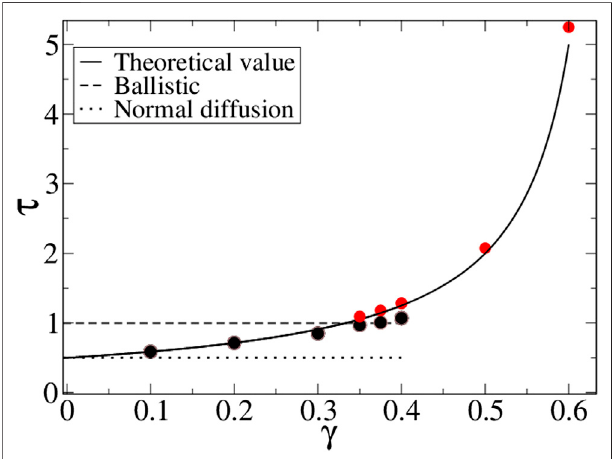
FIGURE6| Simulation results for τ using the fi niterange ( Δ x (cid:1) 1 ) model for c ≤ 0 . 6 (black symbols), and the in fi nite-range model for c (cid:1) 0 . 35 − 0 . 6 (red symbols). The full line is the theoretical values.